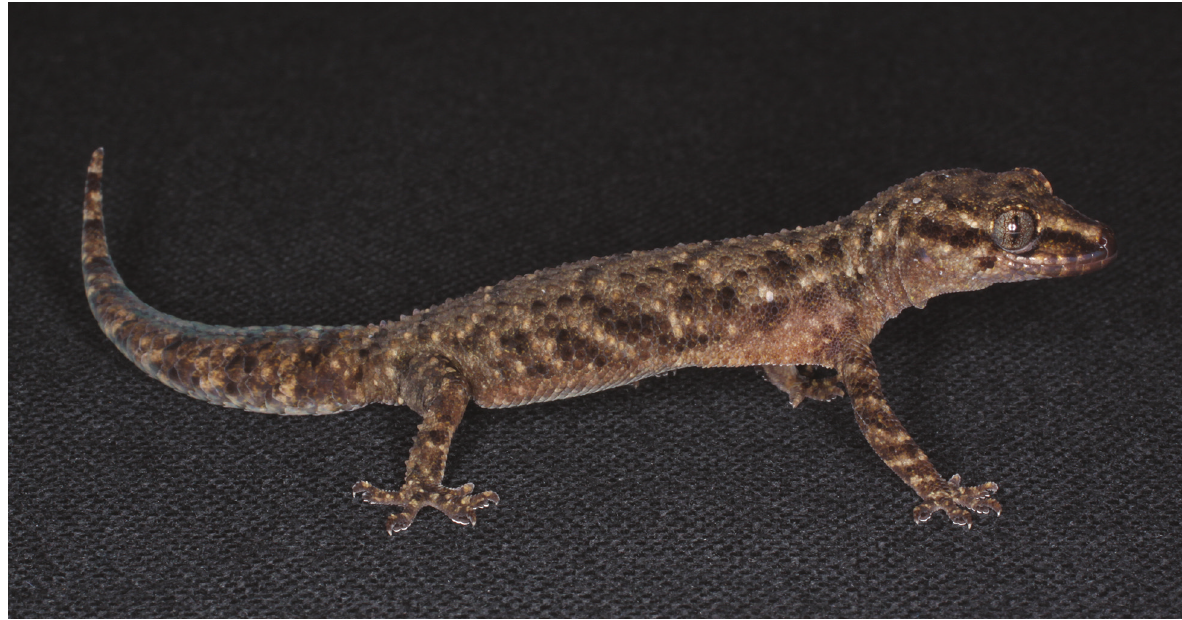
Figure 1. An adult Hemidactylus female (three years old)